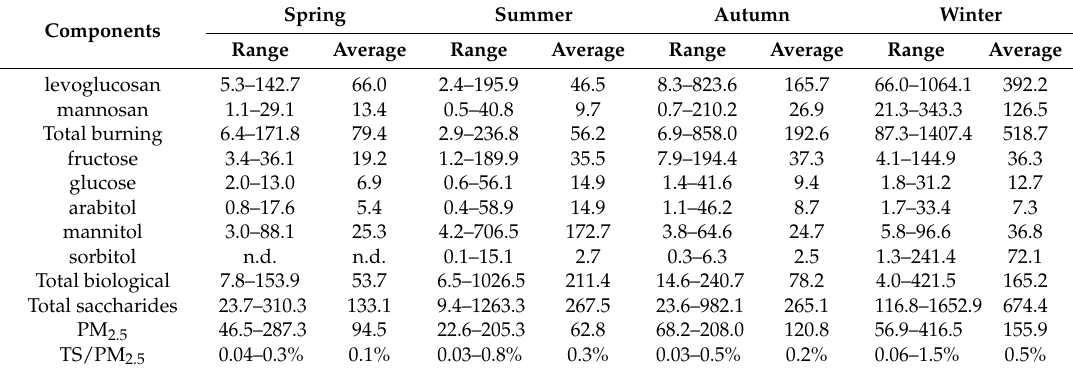
Table 1. Seasonal mean concentrations of measured saccharides (ng/m 3 ) in PM 2.5 samples in Shanghai. Components